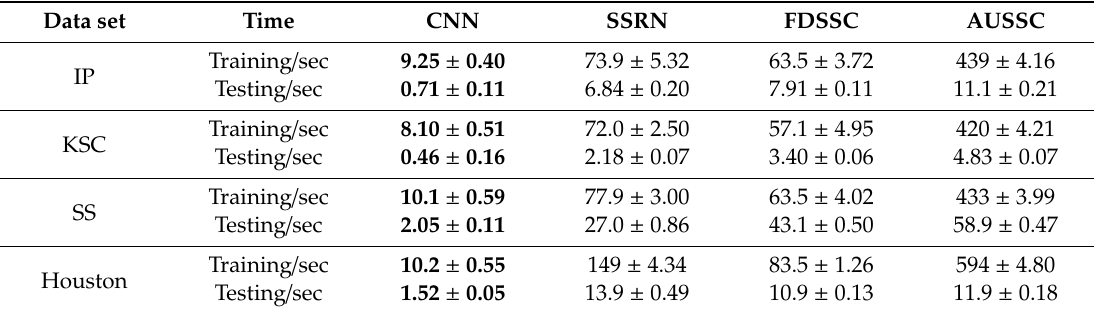
Table 8. Training and testing times for CNN-based methods across the four data